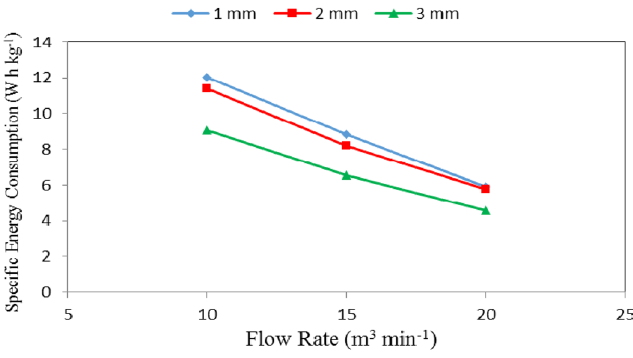
Figure 11. Specific energy consumption at different feed pellet sizes and air flow